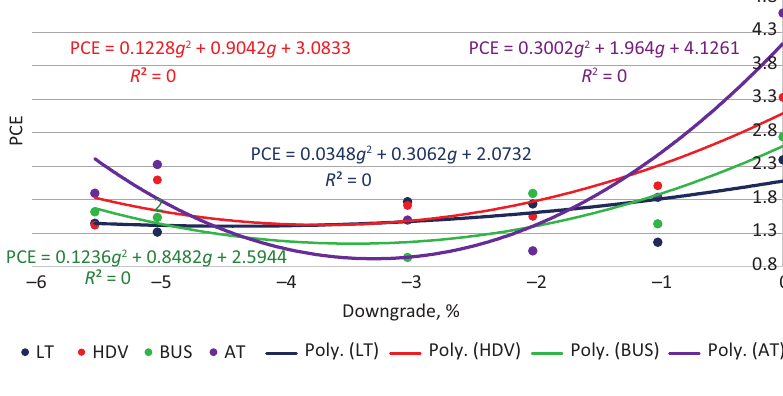
Figure 4. Model for determining PCE values depending on the road downgrade for different categories of vehicles in Bosnia and